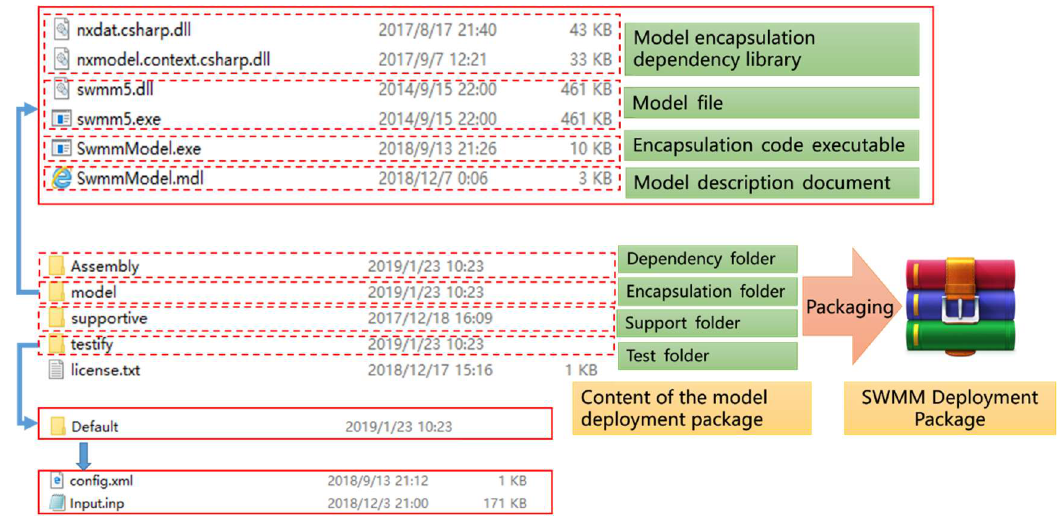
Figure 7. SWMM deployment package.